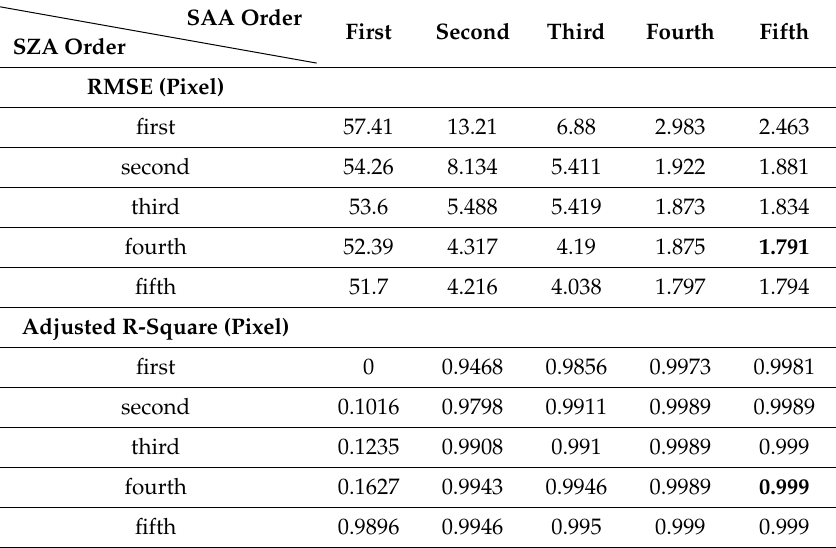
Table 1. Results of the optimal row coordinate